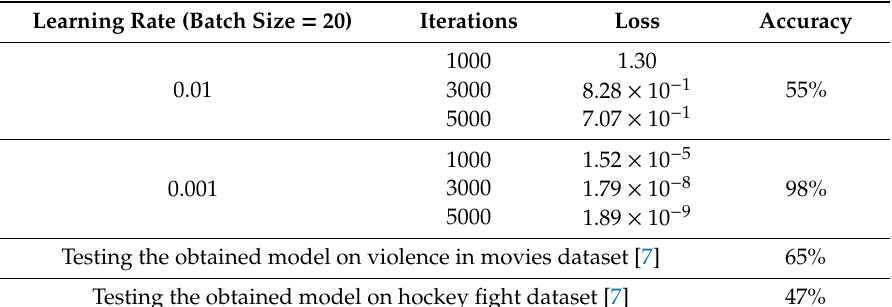
Table 3. Classification accuracies of the proposed method on the violent crowd dataset [14].